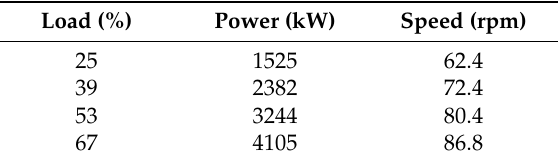
Table 1. Engine operating conditions.